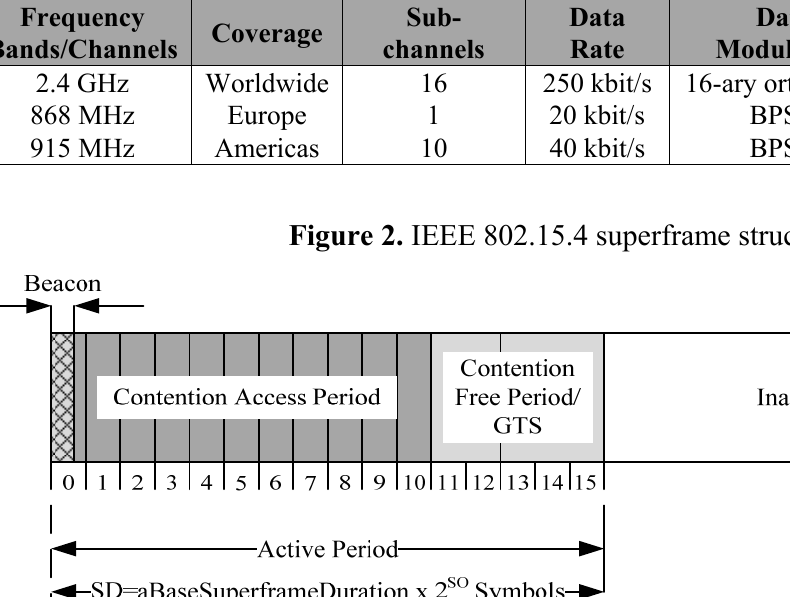
Table 2. IEEE 802.15.4 frequency bands, data rates, and modulation methods.